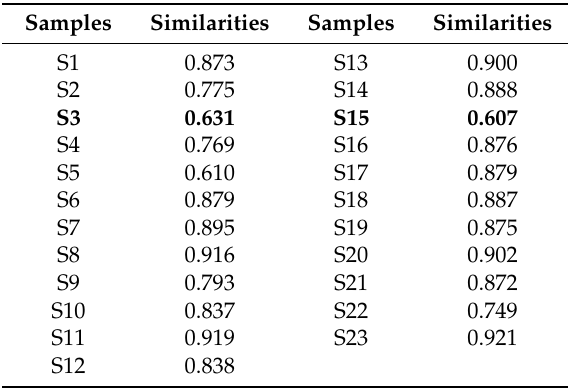
Table 6. The similarities of the chromatograms of PR from each location.